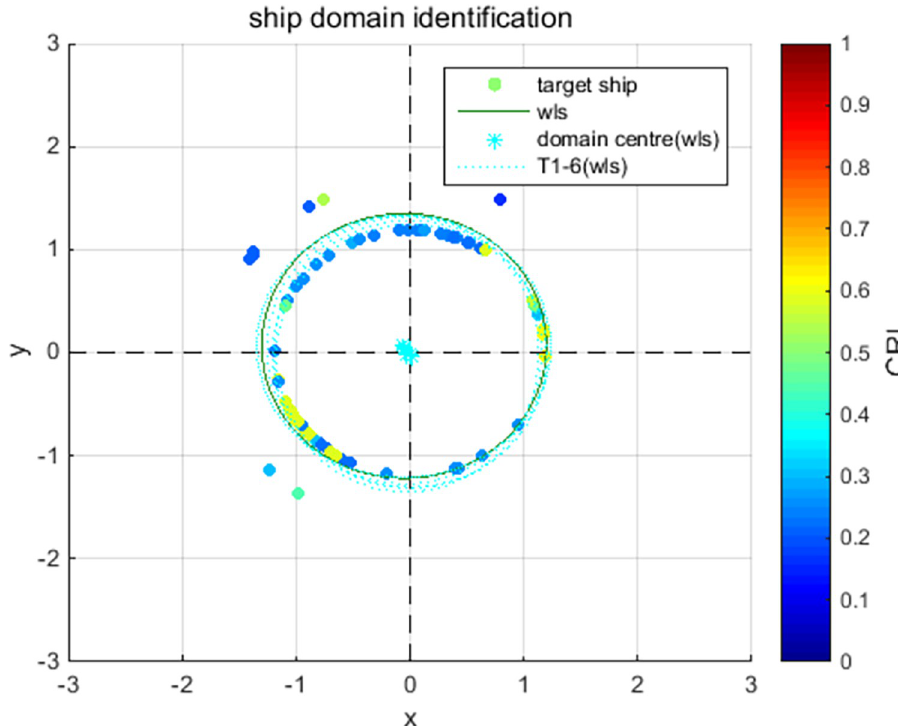
Fig 16. Overlying ship domains by